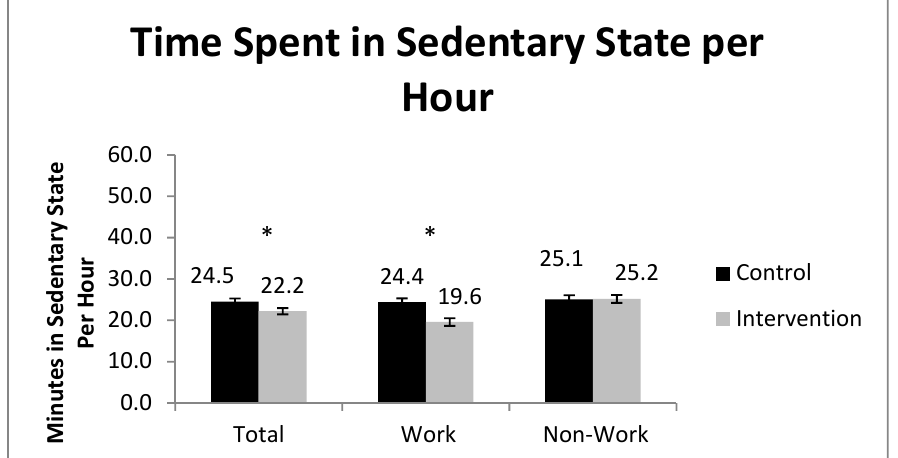
Figure 4. Sedentary time per hour, for total hours, work-hours only, and non-work-hours, measured objectively by the Gruve accelerometer (* p < 0.05). January–April, 2012, Minneapolis, MN,